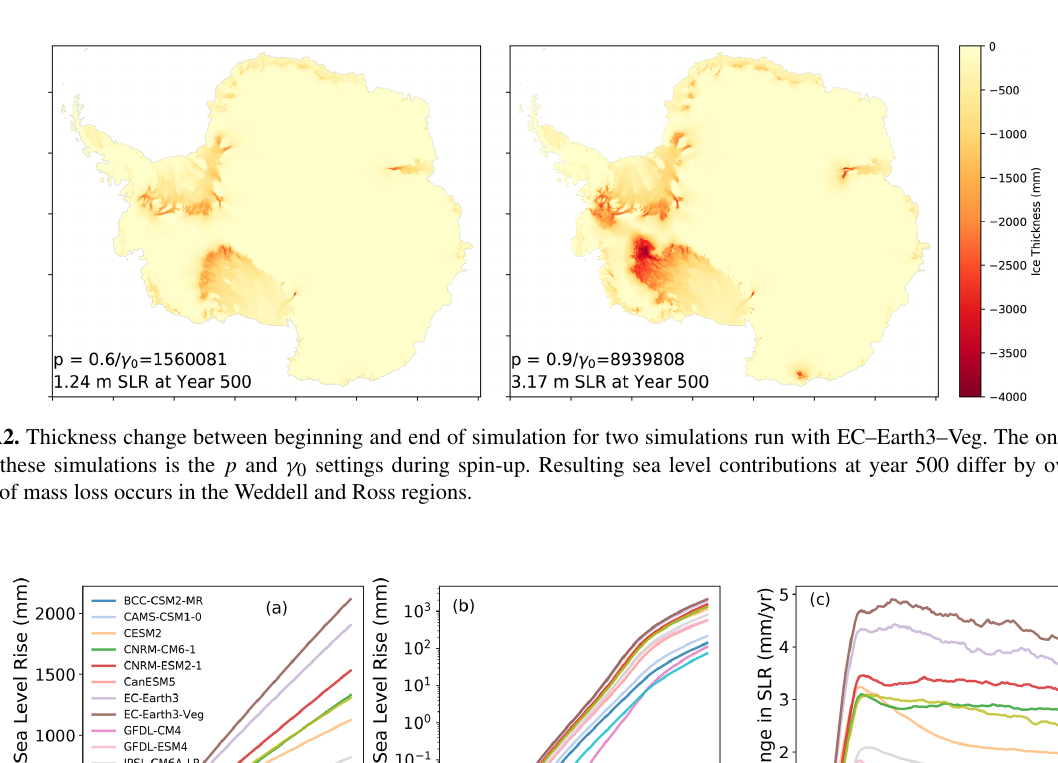
The Cryosphere, 17, 1513–1543, 2023